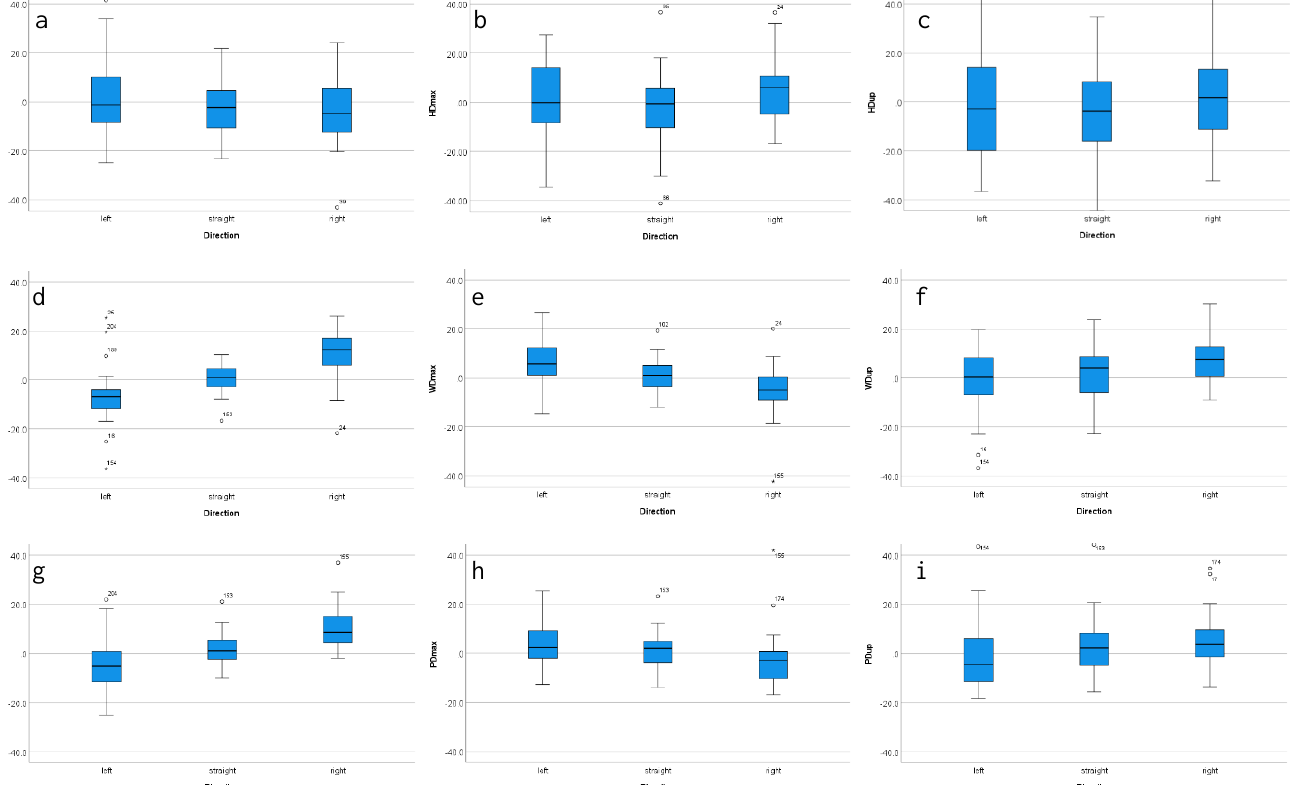
Figure 1. Head, withers and sacrum movement symmetry values (in mm) for N = 30 reining QHs for baseline (‘straight’: in-hand, straight-line) and left and right lunge (‘left’; ‘right’) exercise collected with a 3-sensor inertial sensor gait analysis system on reining-purpose arena footing. Positive asymmetry values indicate ‘right asymmetrical’ movement, negative values indicate ‘left asymmetrical’ movement. ( a ) HDmin, ( b ) HDmax, ( c ) HDup, ( d ) WDmin, ( e ) WDmax, ( f ) WDup, ( g ) PDmin, ( h ) PDmax, ( i ) PDup. Outliers ‘ ◦ ’ defined as data points more extreme than first quartile − 1.5 times interquartile range or more extreme than third quartile +1.5 times interquartile range. Extreme outliers ‘*’ defined as data points more extreme than first quartile − 3 times interquartile range or more extreme than third quartile +3 times interquartile